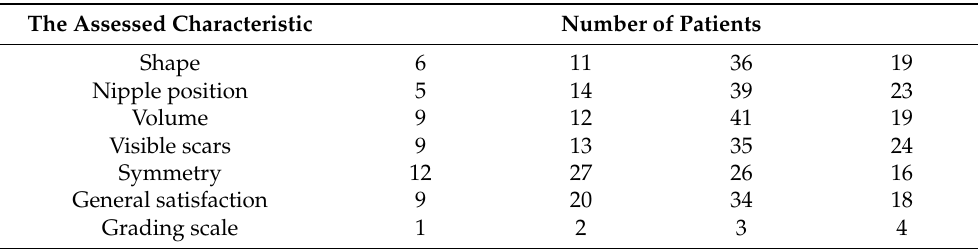
Table A2. Subjective scale of the outcomes of the operation completed by the patients 6 months after radiotherapy.